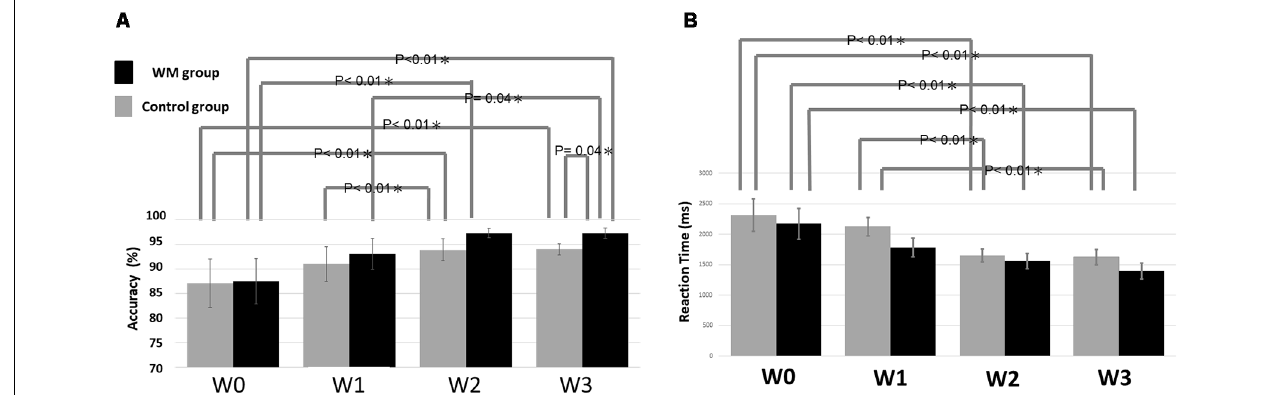
FIGURE 3 | Group-specific mean time courses of the event-related potentials (ERPs) at W0 (red lines) and W3 (blue lines) over channel P8 (A) , T8 (B) , C4 (C) and Pz (D) .